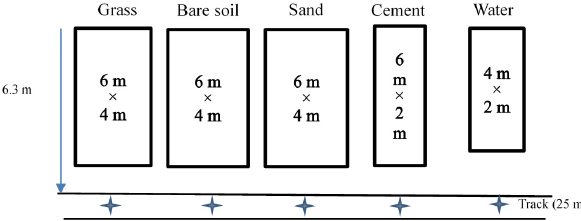
Figure 3. Sketch of the observation field (including five test plots: water, cement, sand, bare soil, and grass), where denotes the po- sition of a touching